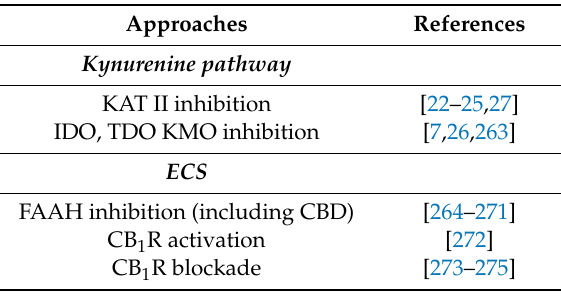
Table 5. A summary of potential therapeutic approaches for schizophrenia by targeting the kynurenine pathway (KP) and